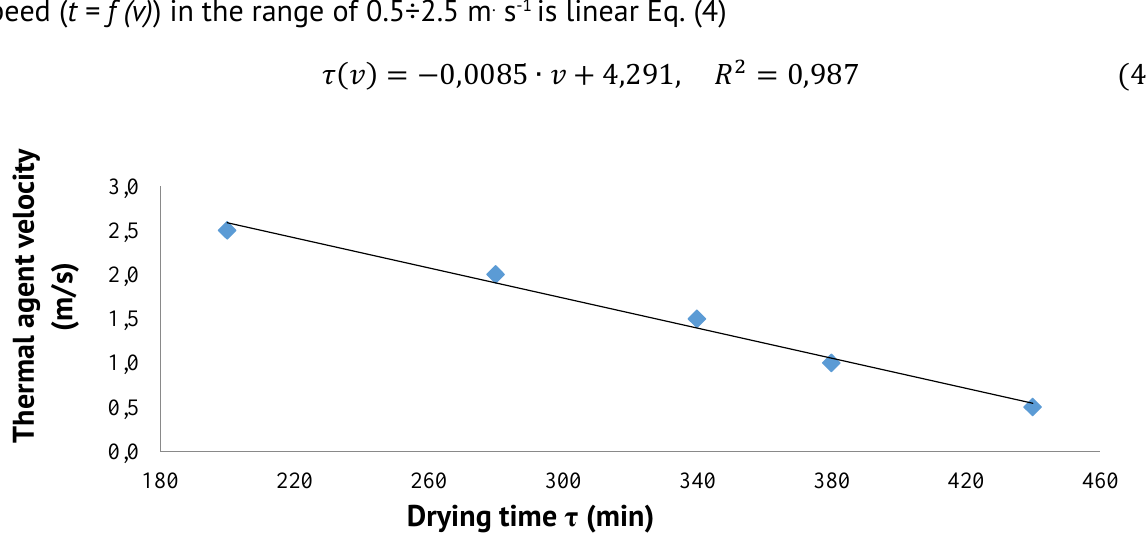
Figure 10. Correlation between peaches drying time and thermal agent velocity (Thermal agent relative humidity 65.0%, thermal agent temperature 60°C, slices thickness 3 . 10 - 3m).